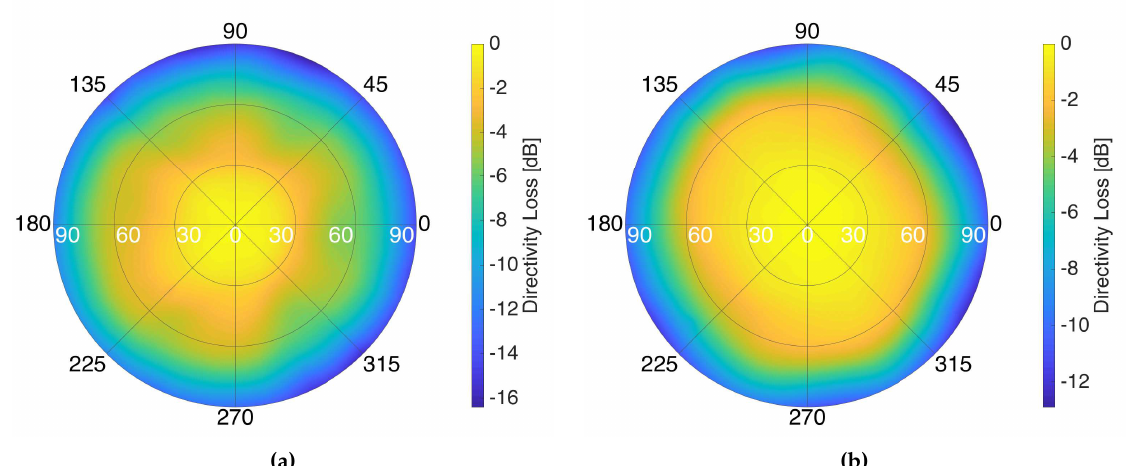
Figure 22. Directivity loss as a function of the pointing direction at L1/E1 ( a ), and at L5/E5 ( b ), for the down-looking